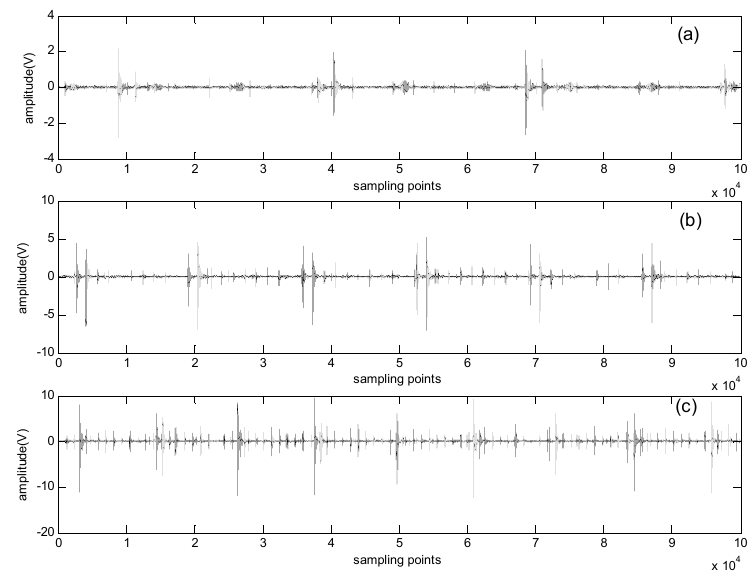
Figure 7. Original signal waveforms obtained at different rotating speeds: ( a ) 500 rpm; ( b ) 900 rpm;